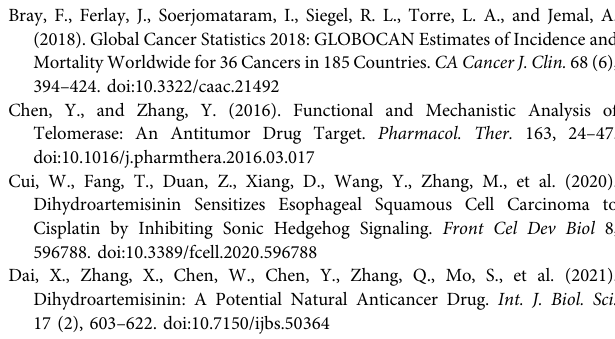
Supplementary Figure S1 | The quantitative results of scratch assay and transwell assay. (A,B) The quantitative results of scratch assay from Figure 1G (A) and quantitative results of transwell assay from Figure 1H (B) . (C,D) The quantitative resultsofscratchassayfromFigure2C (C) andquantitativeresultsoftranswellassay from Figure 2D (D) . (E) The quantitative results of scratch assay and transwell assay from Figures 3E,F. (F,G) The quantitative results of scratch assay from Figure 4F (F) and quantitative results of transwell assay from Figure 4G (G) . (H,I) The quantitative resultsofscratchassayfromFigure4J (H) andquantitativeresultsoftranswellassay from Figure 4K (I) . (* indicate p < 0.05, ** indicate p < 0.01, and ***indicate p < 0.001 compared with control.) Supplementary Table S1 | Clinical parameters of 32 ESCC patients association with hTERT expression